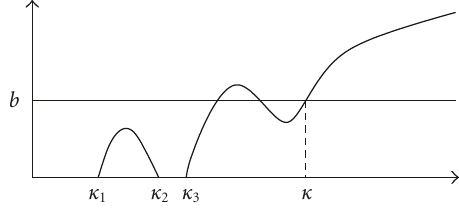
Figure 3.2 . Graph of ψ ( h ) (Theorem